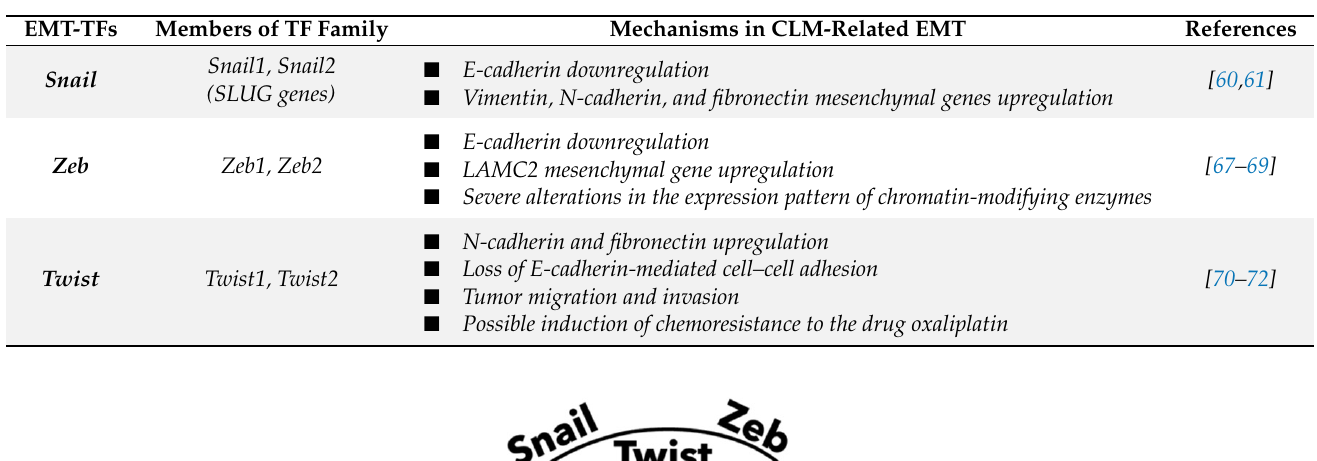
Table 1. EMT transcription factors and their role in EMT mechanisms to promote CLM development.